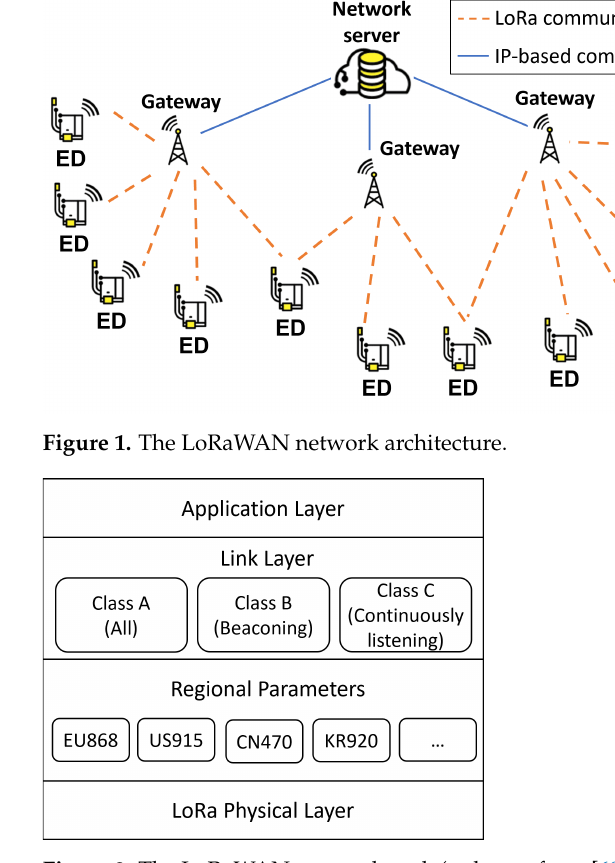
Figure 2. The LoRaWAN protocol stack (redrawn from